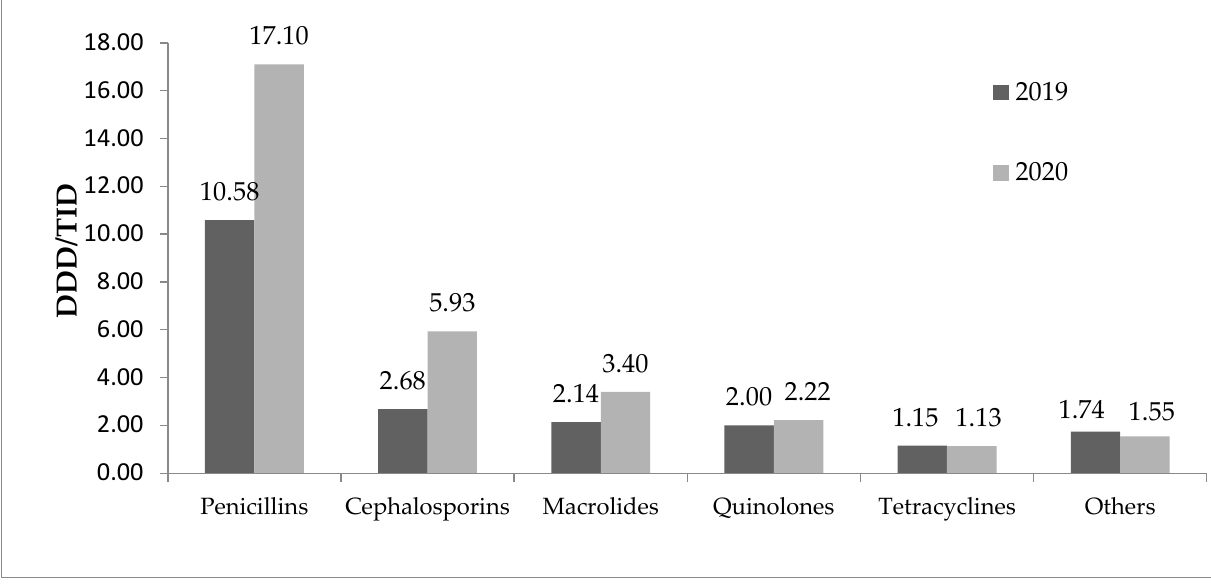
Figure 1. Consumption of antibiotics for systemic use before and during COVID-19 pandemic. DDD/TID—defineddaily dose per 1000 inhabitants.